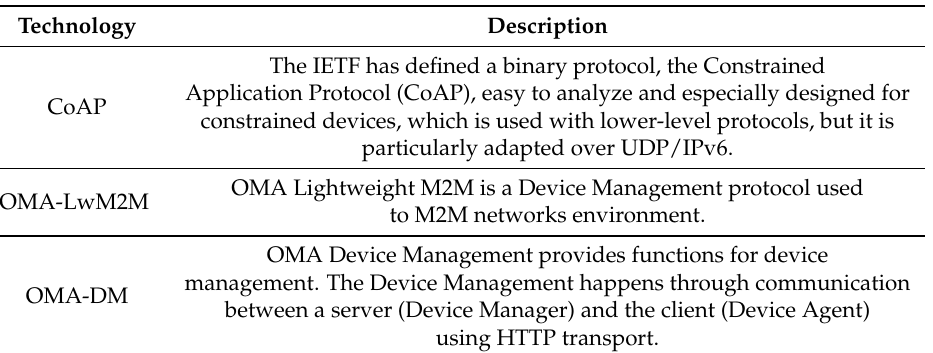
Table 3. COMAN—Candidate